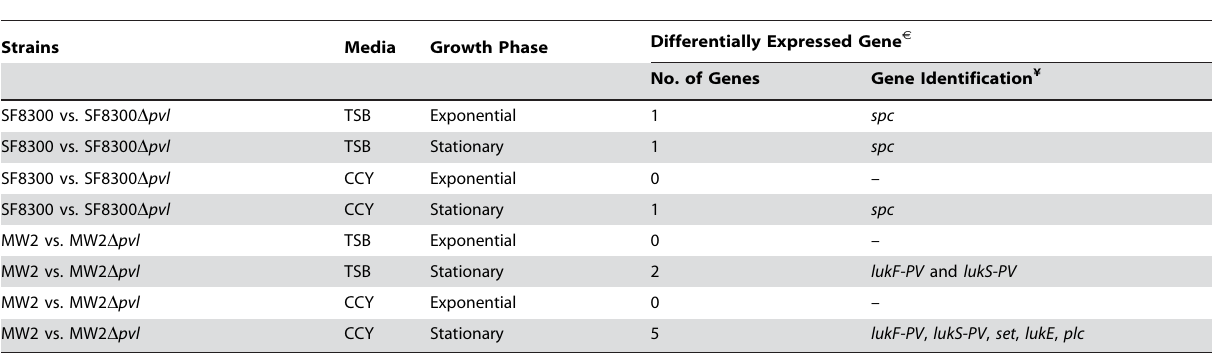
Table 1. PVL does not alter global transcriptional profiles of USA300 and USA400.*